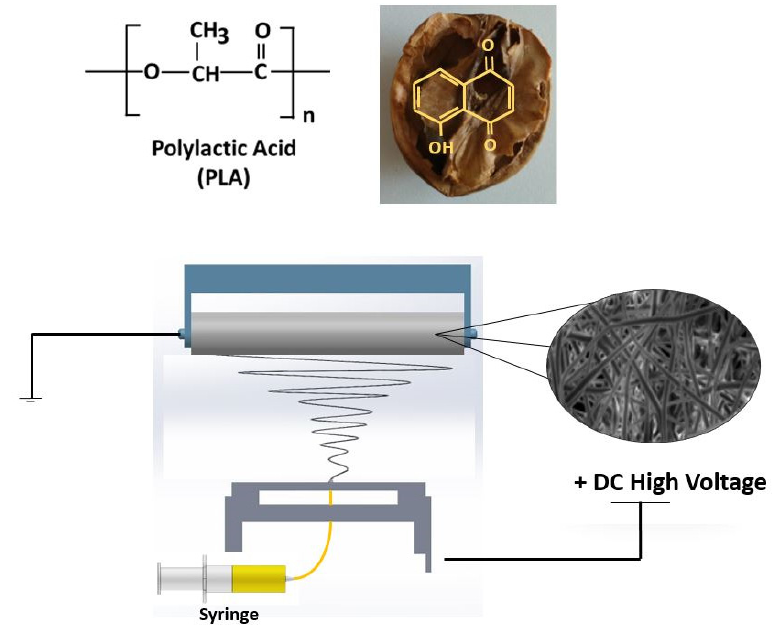
Figure 1. The schematic illustration of the setup.